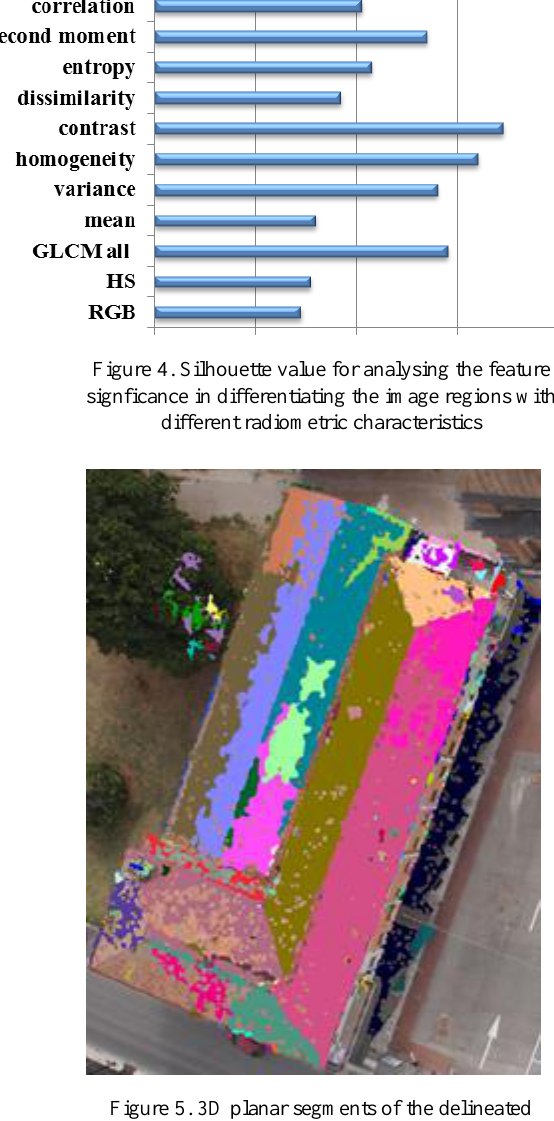
Figure 2. Building delineation from 3D point cloud